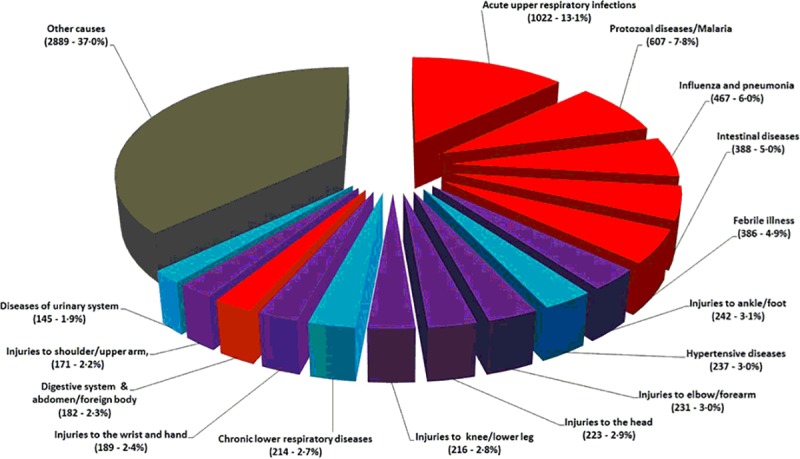
Top 15 diagnoses in the MOZART cohort (representing 63% of all diagnoses)–ICD10 coding.Red segments = CD, Blue segments = NCD, Purple segments = Injury and Grey segment = other diagnoses comprising CD, NCD and Injury.